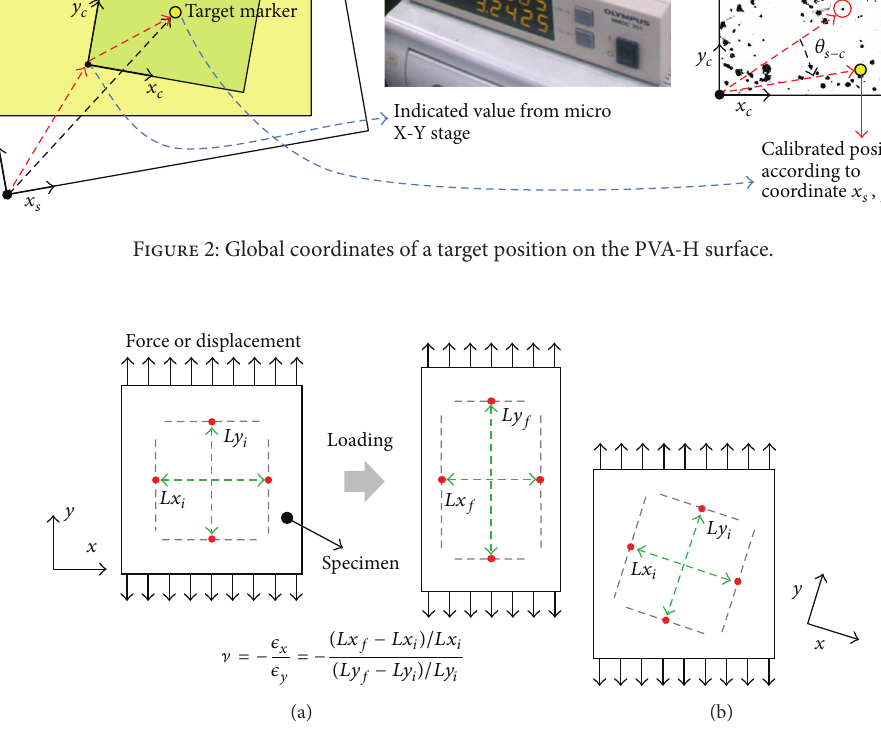
Figure 3: Schematic of the standard method of calculating Poisson’s ratio—(a) Poisson’s ratio calculation on a 2D plane and (b) misalignment between coordinates and loading